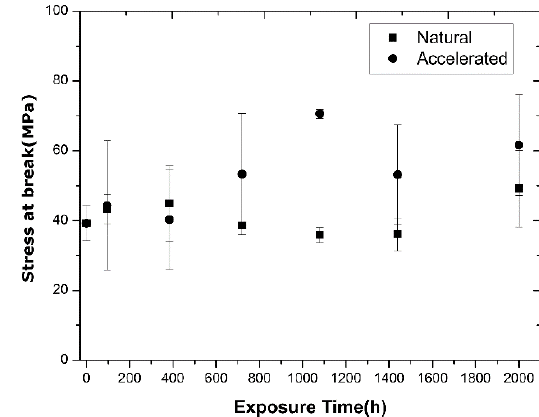
Figure 8. The stress at break as a function exposure time for natural and accelerated photoaging.